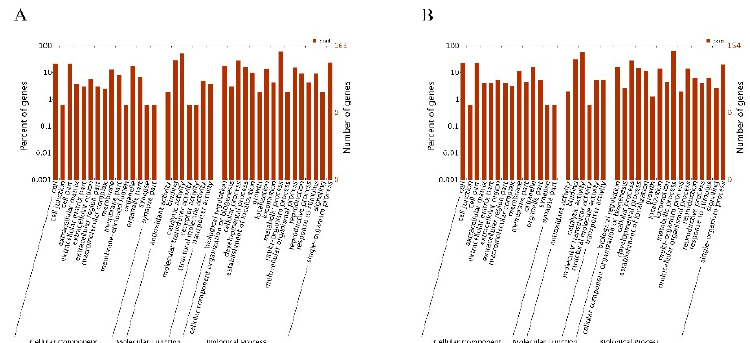
Figure 5. GO assignment of the DEGs in the AD and AG transcriptomes. DEGs in the AD sample ( A ) and in the AG sample ( B ) had GO ID assignments mainly in three categories: cellular component, molecular function, and biological process.